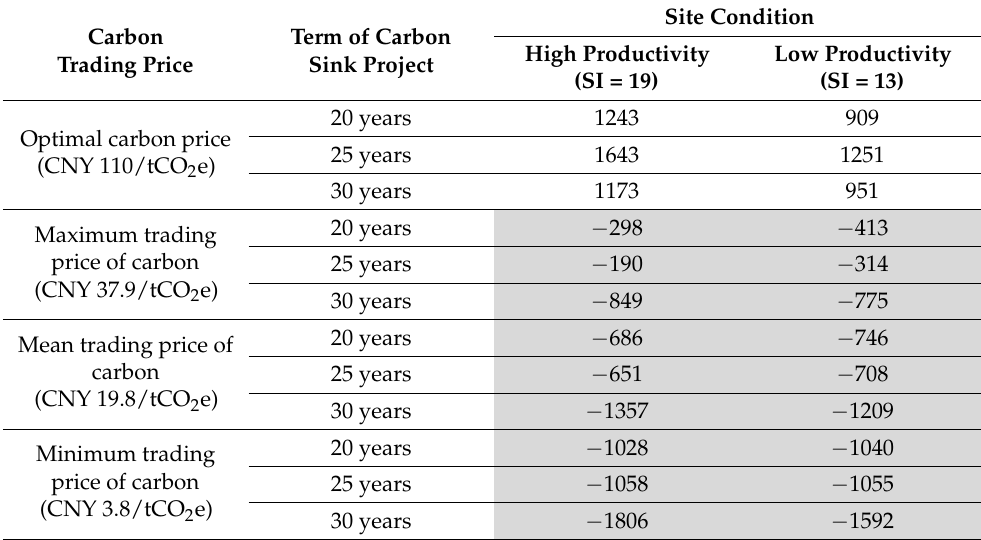
Data source: National Forestry and Grassland Administration of China [8]. Table A3. Incremental land expectation values (net benefits) of enrolling in a larch carbon sink plantation project compared with managing the forestland for timber production in northwestern China (evaluated with no penalty on carbon leakage at the time of